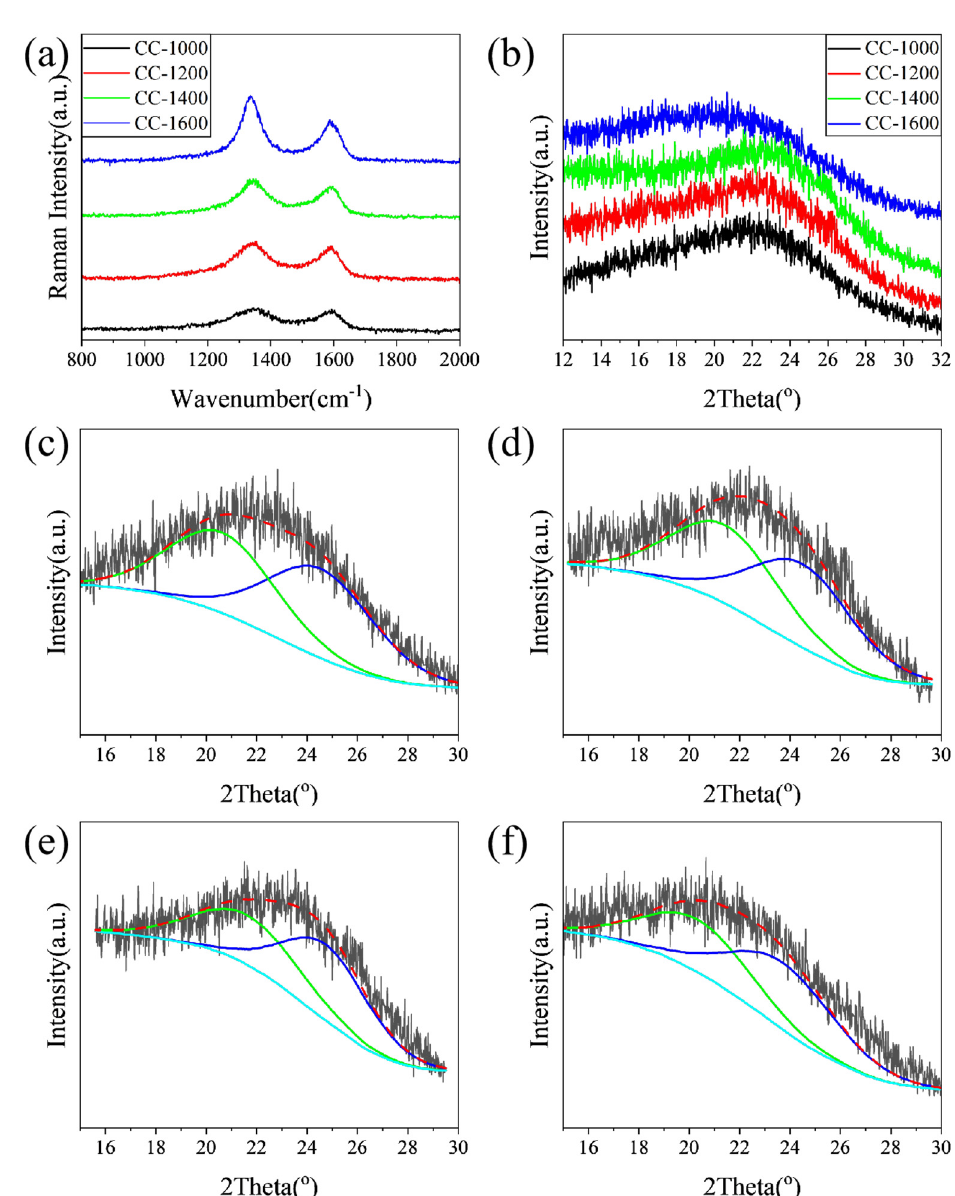
Figure 3. ( a ) Raman spectra; ( b ) XRD patterns of the all as-obtained samples; the (002) peak fitting curves of the XRD pattern of ( c ) CC-1000, ( d ) CC-1200, ( e ) CC-1400, and ( f ) Table 1. Physical parameters calculated by XRD and Raman pa tt erns of the as-obtained samples.